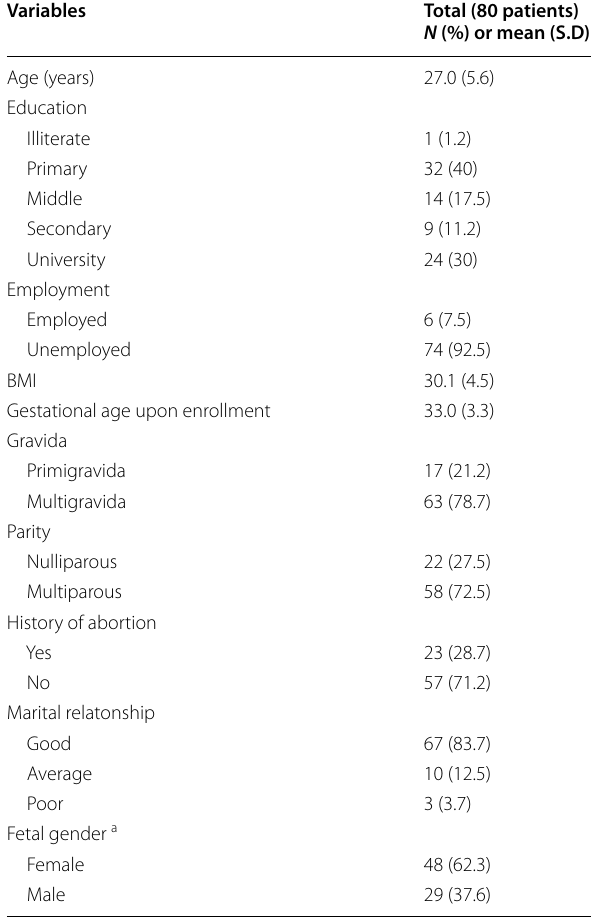
Table 1 Sociodemographic and obstetric characteristics of the study